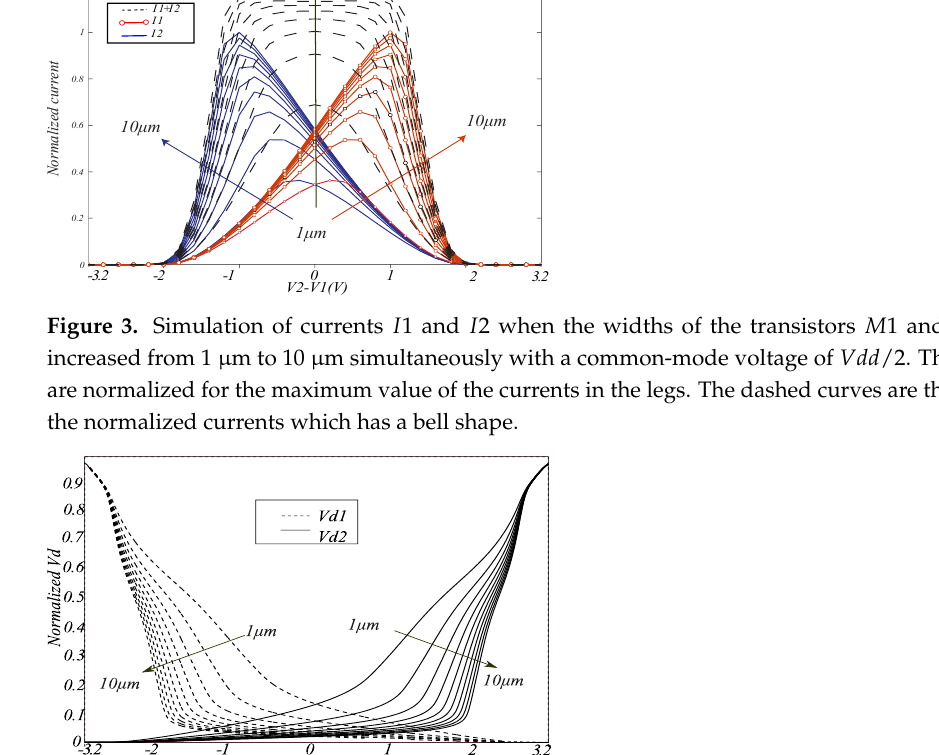
Figure 4. Simulation results of voltages Vd 1 and Vd 2 when the widths of the transistors M 1 and M 2 are increased from 1 µ m to 10 µ m simultaneously.